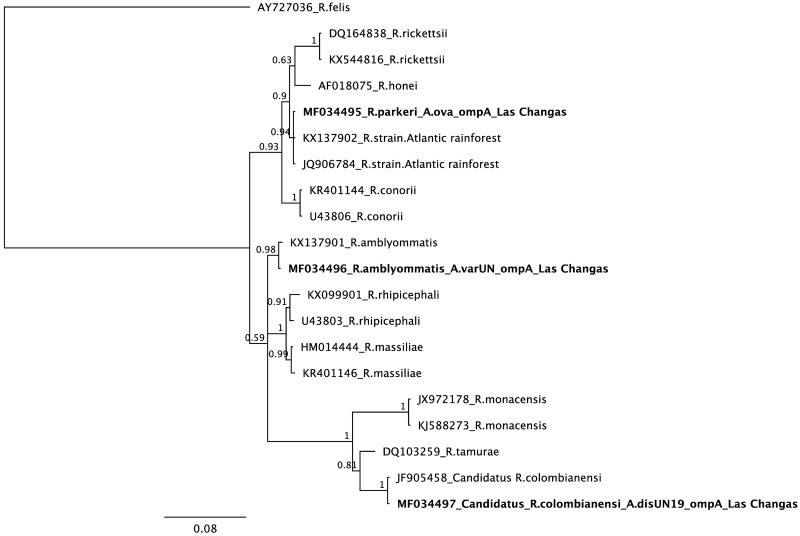
Bayesian phylogenetic analysis of ompA (TPM3uf+I model).